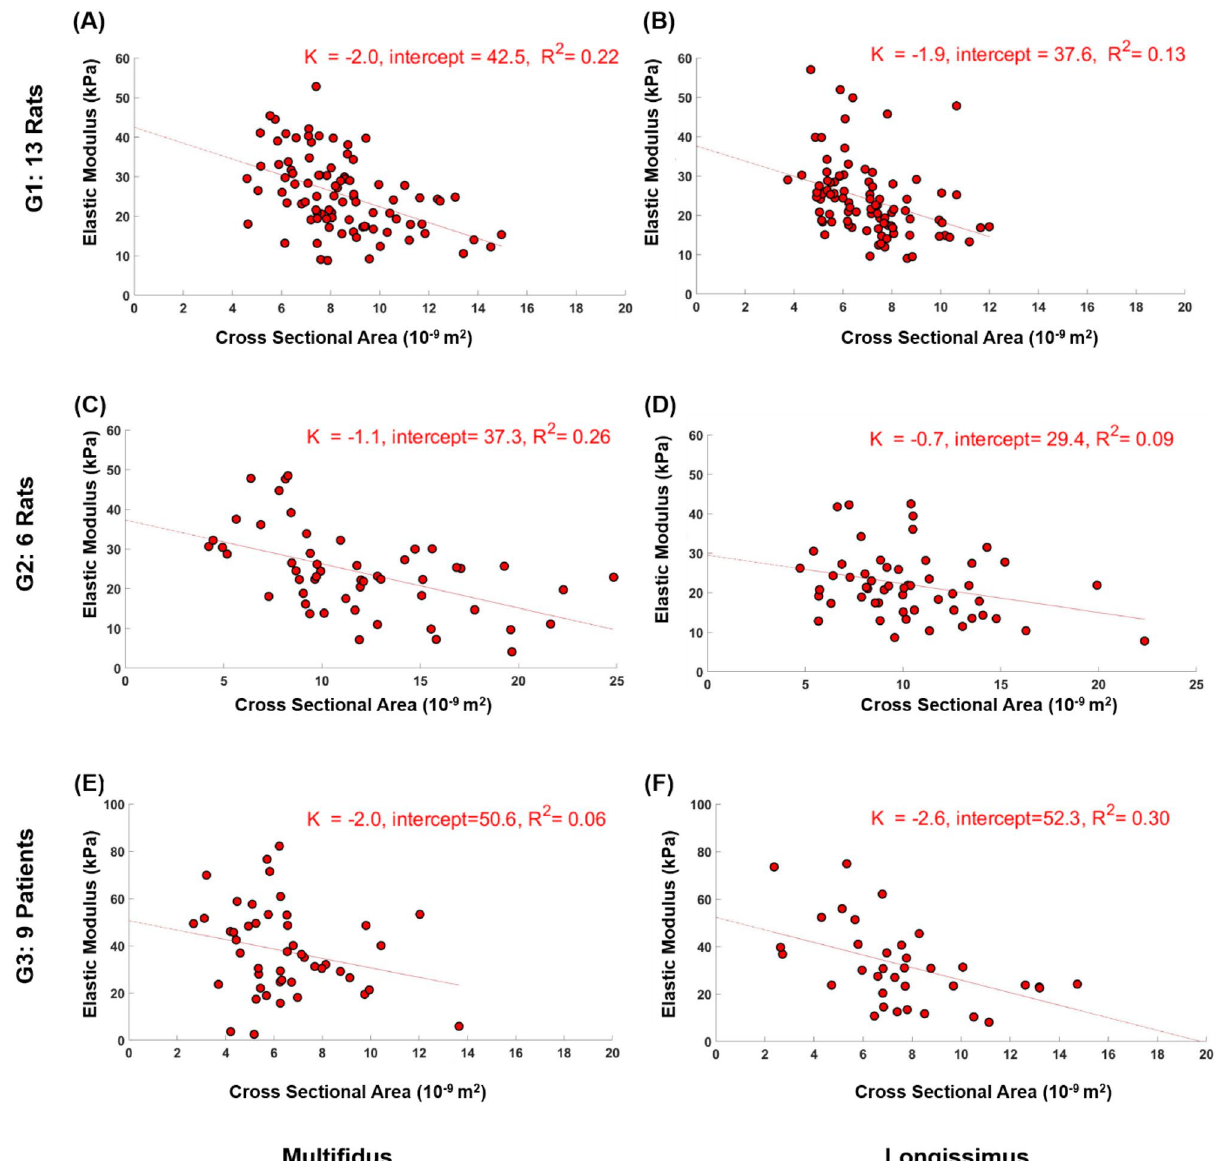
Figure 2. Correlation between cross sectional area and elastic modulus of single fibers from multifidus and longissimus of G1 ( A , B ), G2 ( C , D ), and G3 ( E , F ). All P < 0.026 except for G3 multifidus